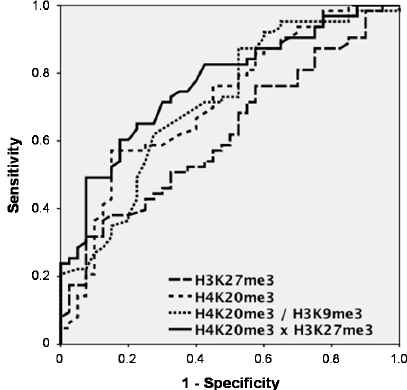
Figure 2. Receiver operating characteristic (ROC) curves indicating the sensitivity-specificity profile for the discrimination between patients with colorectal cancer (CRC) and non-malignant controls over the whole range of possible cutoffs for the significantly discriminating marks H3K27me3 and H4K20me3, as well as for the combinations H4K20me3/H3K9me3 and H4K20me3 × H3K27me3 determined by ELISA.